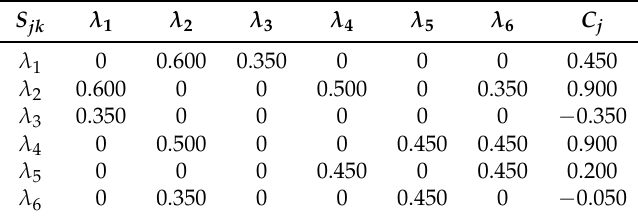
Table 5. Score and choice values of complex neutrosophic line graph.